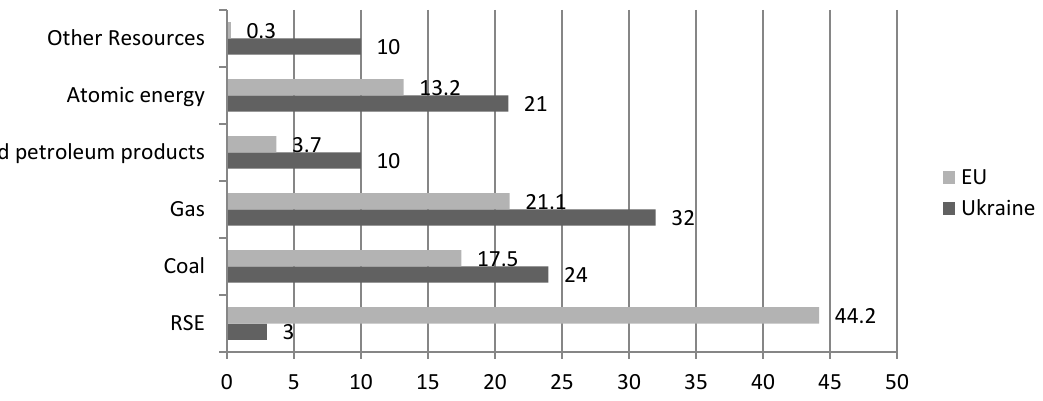
Figure 1. Structure of energy resources supplying in EU and Ukraine in 2015,